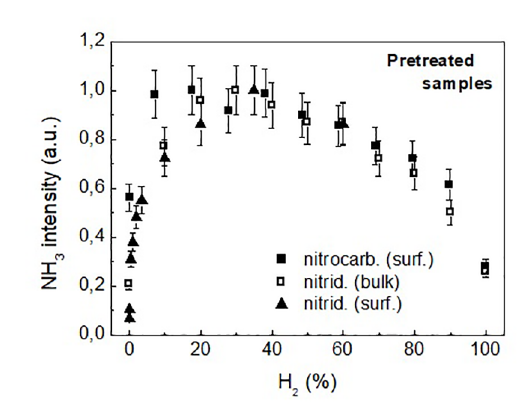
+ ) obtained 3 Figure 10. Comparison of the evolution of the ammonia ion peak (NH3 + ) obtained during nitriding (bulk configuration) and nitrocarburizing (surface configuration) process with Szabo’s